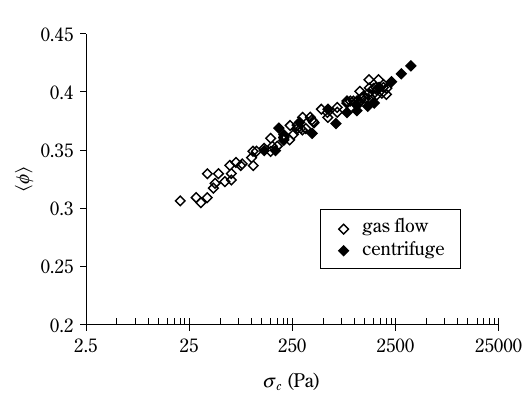
Average particle volume fraction as a function of the con- solidation stress for a toner of 12.5 µ m particle size and 40% SAC. The external pressure is applied by means of a gas flow (void symbols) and by means of centrifugation of the cell (solid symbols).